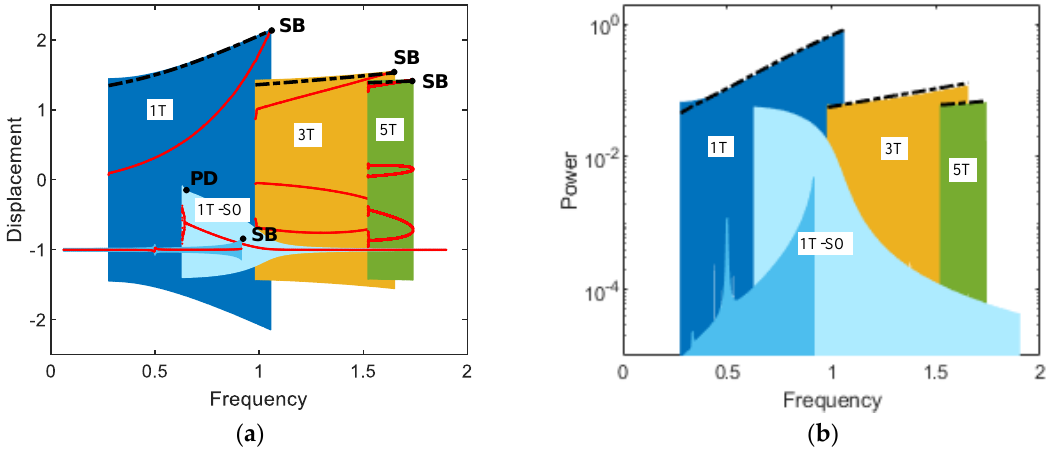
Figure 3. Frequency responses for ( a ) displacement and ( b ) output power of the electromagnetic bi-stable energy harvester obtained when A = 0.02: (1 T ) primary harmonic period- T interwell motion, (1 T -SO) period- T intrawell motion, (3 T ) subharmonic period-3 T interwell motion, and (5 T ) period-5 T interwell motion. The saddle-node bifurcations and period- doubling bifurcation are designated by points SB and PD, respectively. In ( a ), the red dots indicate the stroboscopic projections of the oscillations, which are synchronized with the period T of the base excitation. The dashed-dotted lines are the harmonic balance solutions for the primary harmonic and subharmonic interwell motions, which will be discussed in Section 4.